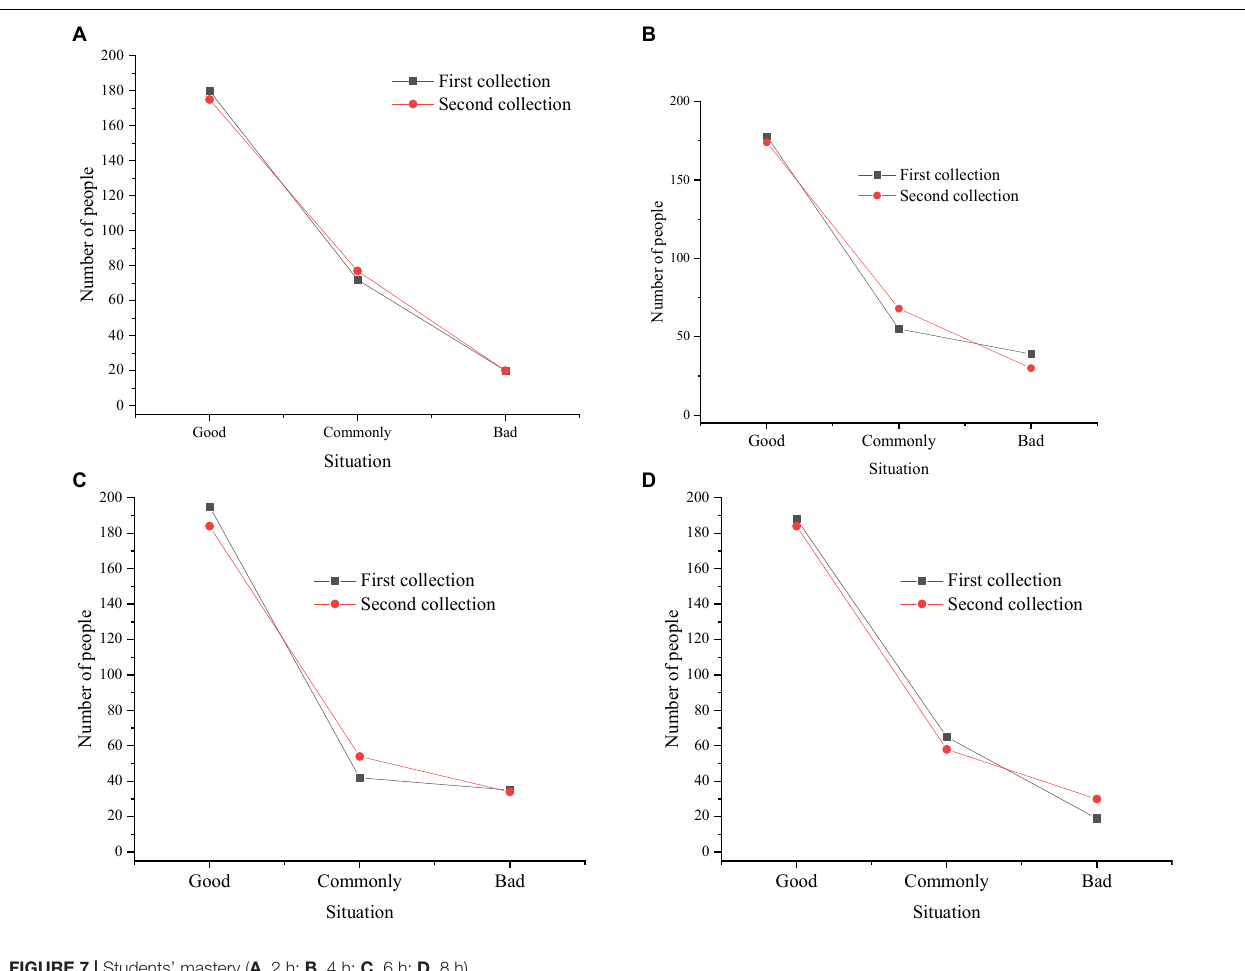
FIGURE 7 | Students’ mastery ( A , 2 h; B , 4 h; C , 6 h; D , 8 h).